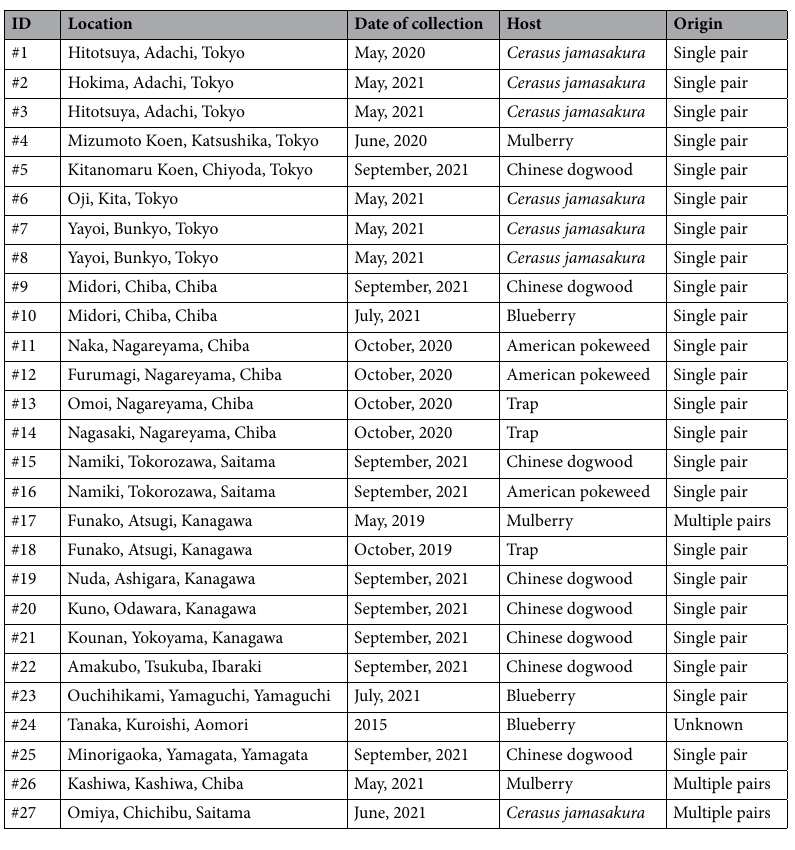
Table 1. List of